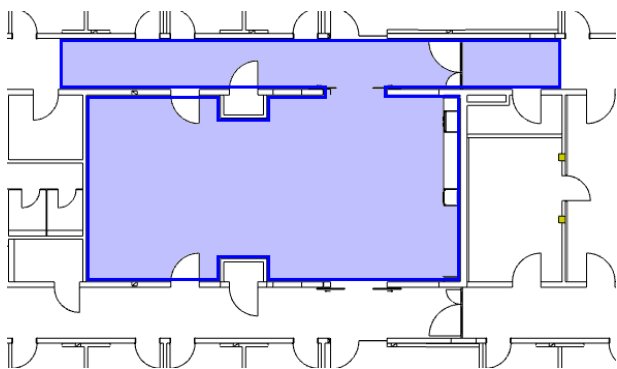
Figure 2. Blueprint of the room and the neighbouring corridor—marked in blue in the picture—in which the user test took place. The surface of the room is approximately 85 m 2 .